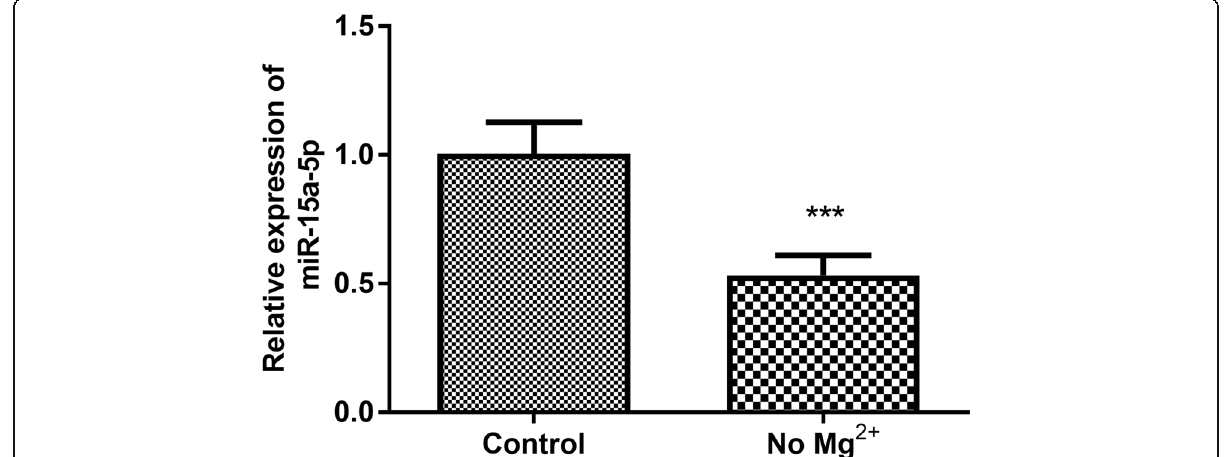
Fig. 3 To mimic TLE condition in children, primary hippocampal cells were collected from newborn rats, and cultured in the magnesium-free medium for 3 h to establish TLE cell model. The expression level of miR-15a-5p was decreased significantly in hippocampal cells treated in magnesium-free medium. *** P < 0.001